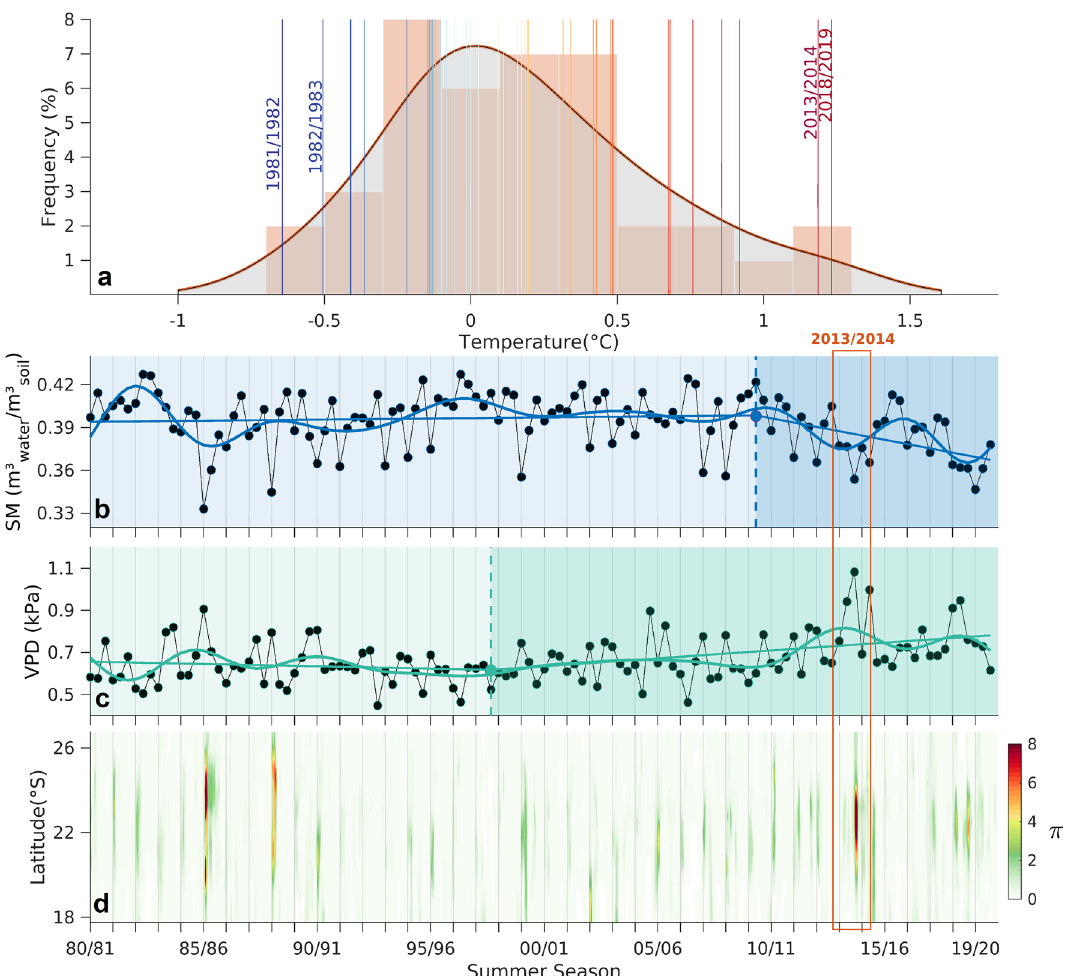
Figure 3. Analysis of the extreme summer hot and dry conditions during the 2013/2014 summer in a historical evolution perspective. Kernel distribution function for the average summer temperature anomalies (°C) from 1980 to 2020 observed for the region within the grey box shown in Figs. 1 and 2 ( a ) . The vertical colored lines indicate the mean surface temperature anomaly values for each summer season. Historical evolution from 1980 to 2020 of monthly mean summer soil moisture ( m 3 water / m 3 soil ) and vapor pressure deficit (kPa) values ( b, c , respectively). The bold lines result from the application of a 10-year low-pass Lanczos filter and a linear regression model with two segmented (i.e., piece-wise) linear relationships separated by a break point (obtained from an iterative process described in Supplementary Material) highlighted by the filled colored dot. The monthly mean values result from area averages applied for the region within the grey box in Figs. 1 and 2. Mean daily π coupling metric per each 0.25° latitude within the grey box shown in Figs. 1 and 2, for the summer seasons from 1980 to 2020 ( d